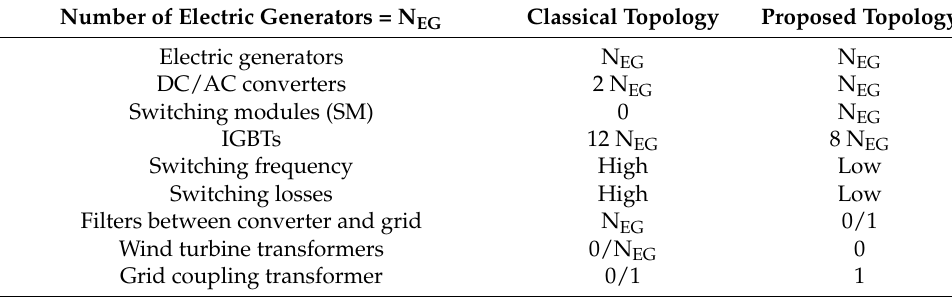
Table 2. Summary of the main differences between the two